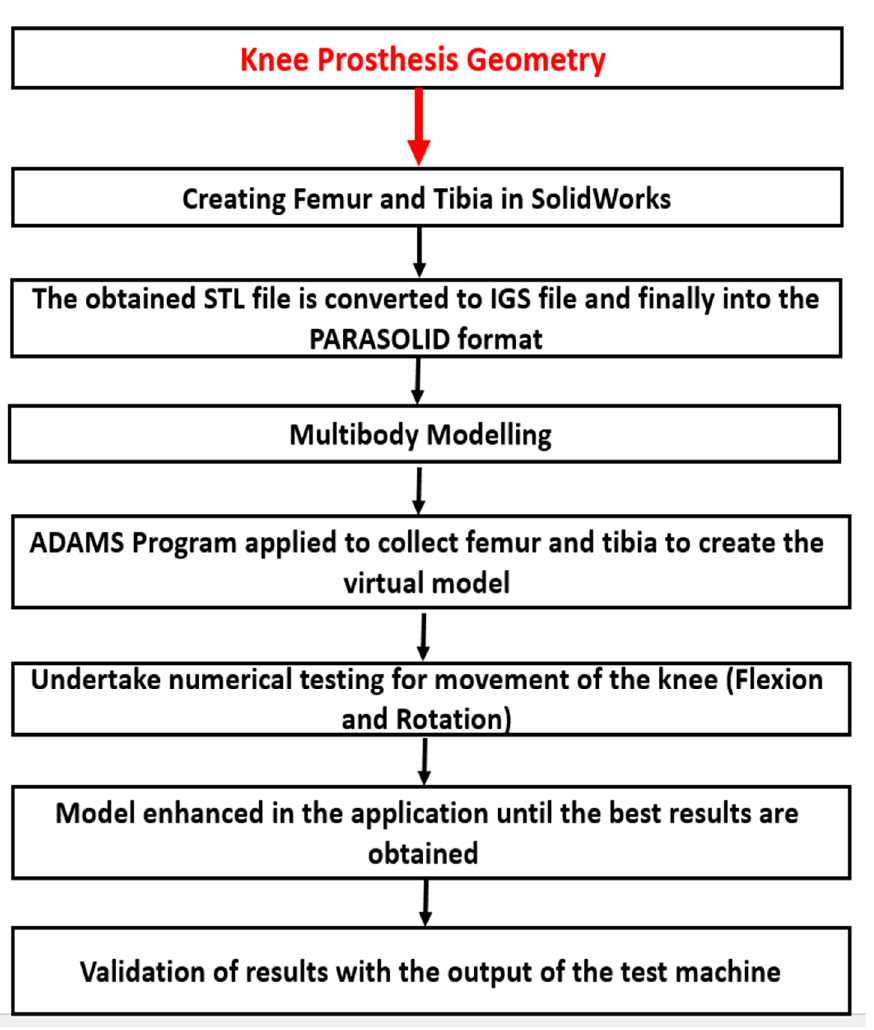
Figure 6. Block diagram showing the applied steps.